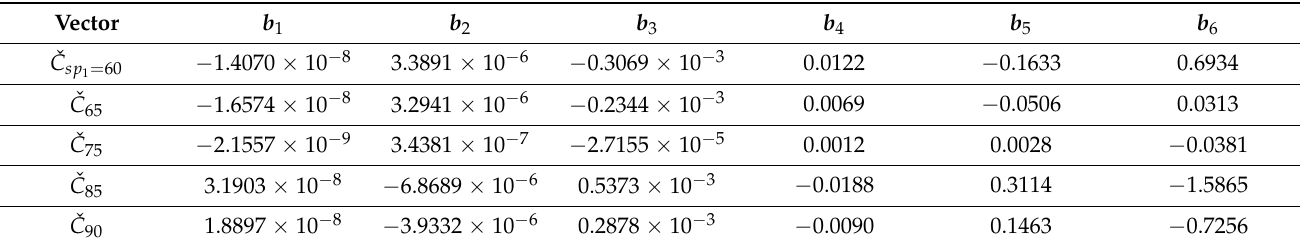
parameters’ values (procedure 5). 1